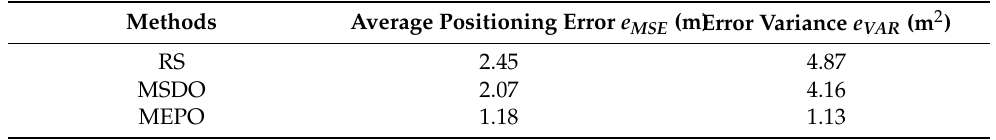
Table 3. Comparison of localization effects of different anchor nodes selection methods in path 1. Methods